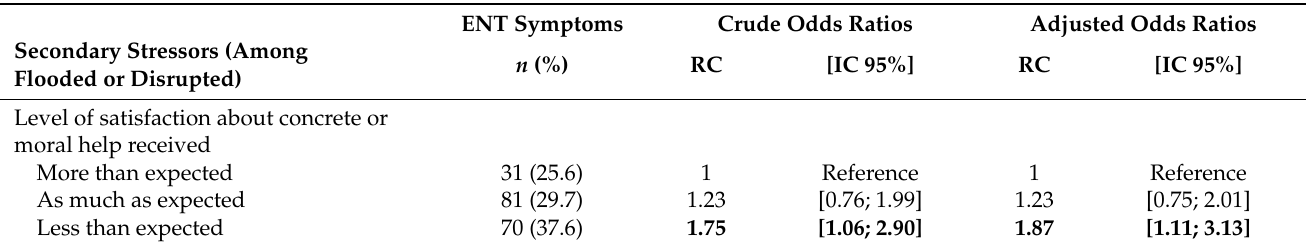
Table 6. Associations between secondary stressors and ENT and respiratory symptoms in all